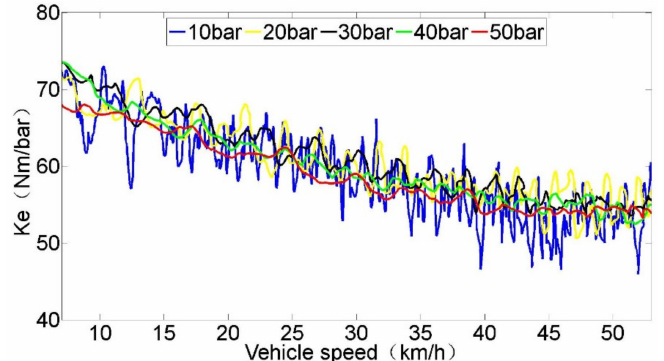
Figure 11. Evolution of K e under different brake